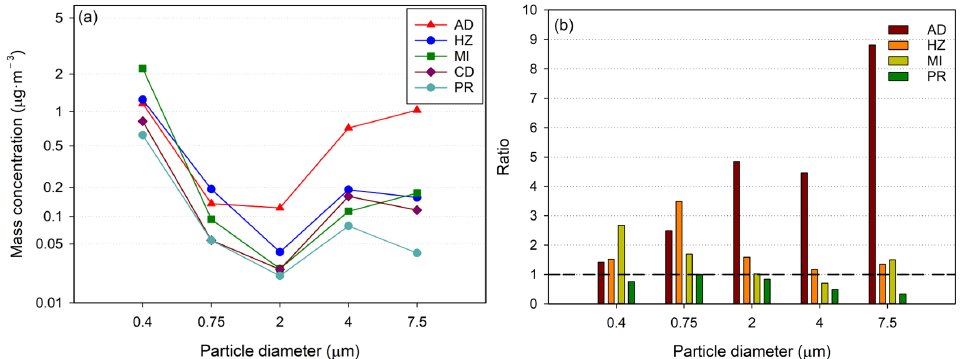
Figure 6. ( a ) Aerosol mass concentration size distribution for the AD, HZ, MI, PR, and CD cases. ( b ) The proportion of mass concentration for each phenomenon (AD, HZ, MI, and PR) by particle size compared with CD conditions (dashed line).